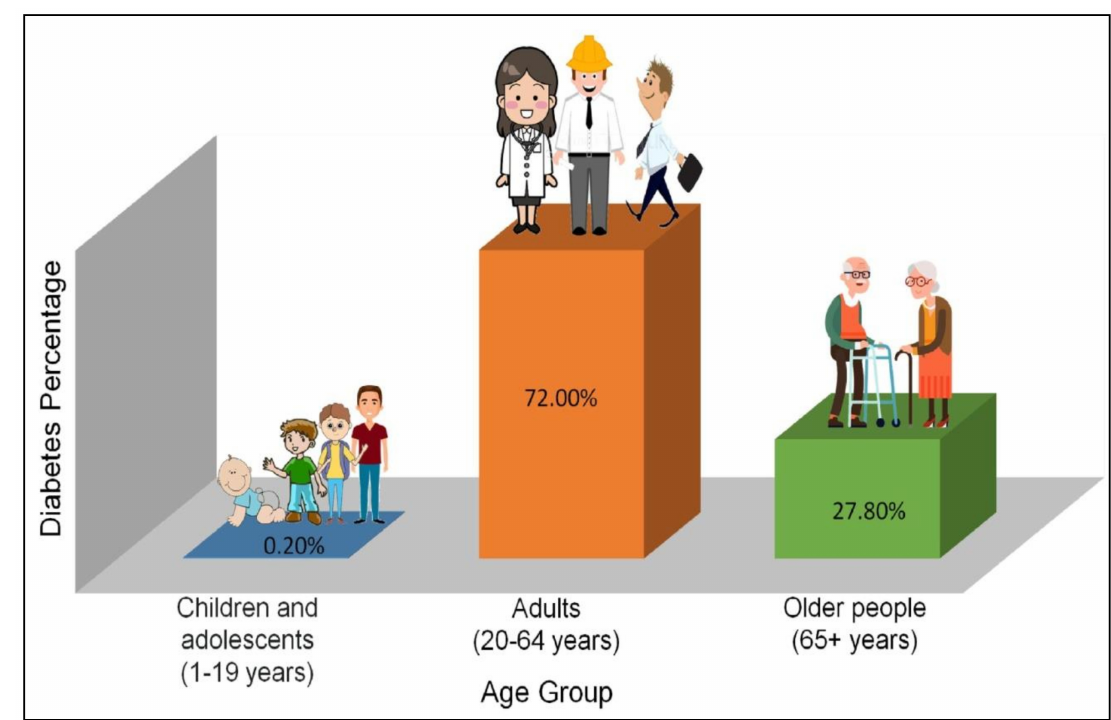
Figure 1. Statistics of diabetic persons in different age groups. As per geographical analysis, the IDF Western Pacific region shows the highest age- adjusted prevalence of diabetes: 163 million, 197 million, and 212 million in adults for the year 2019, 2030, and 2045, respectively. On the contrary, the IDF Africa (AFR) region has the lowest age-adjusted rates: 19 million, 29 million, and 47 million for the same estimated years [4], partially due to malnutrition, low levels of obesity, and urbanization. Nevertheless, in this region, by 2045, the number of diabetic people is expected to rise by 143%, the highest increasde in all regions over that time (Figure 2) [5].